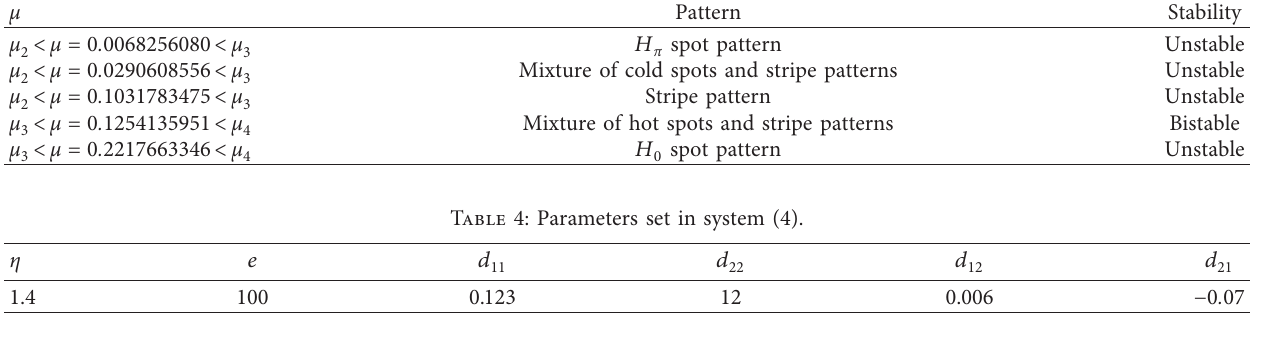
Table 5: Parameters calculated in system (4).